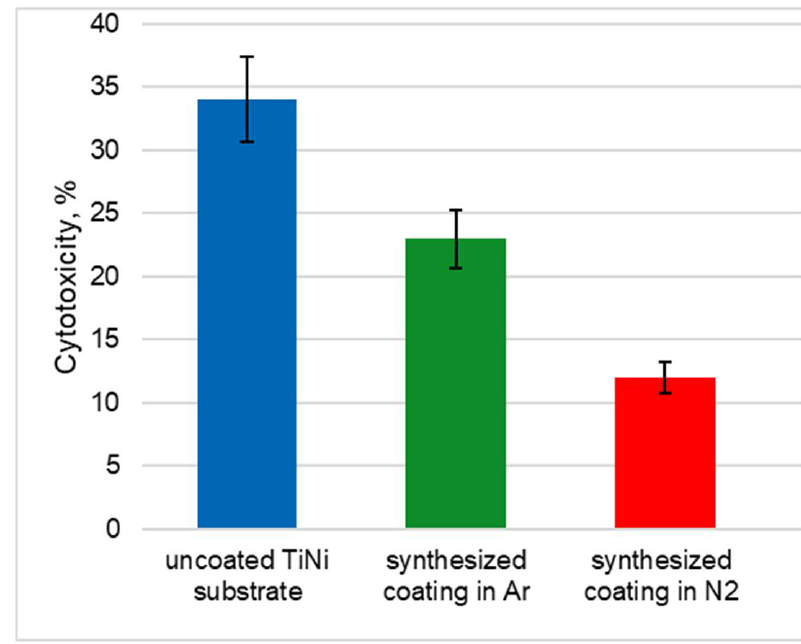
Figure 3. Cytotoxicity towards MCF-7 cells after 24 h.